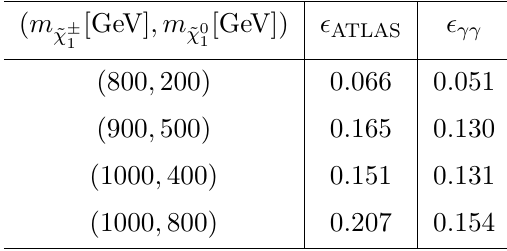
Table 6 . Selection efficiencies from [31], (cid:15) ATLAS , and from this paper, (cid:15) γγ , for different mass